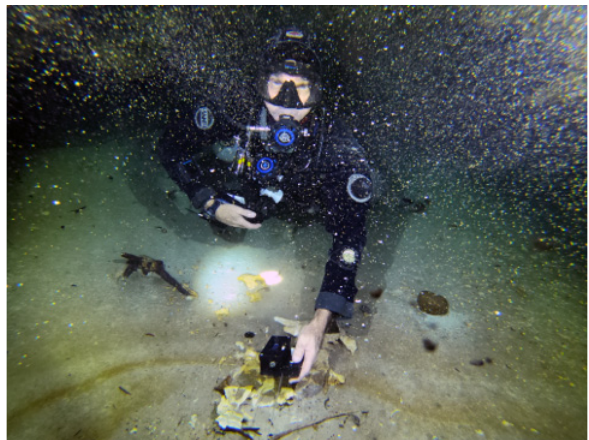
Figure 4 . Percolation in an underwater cave: sediments dislodged from the ceiling and creating intense backscatter (CINDAQ)